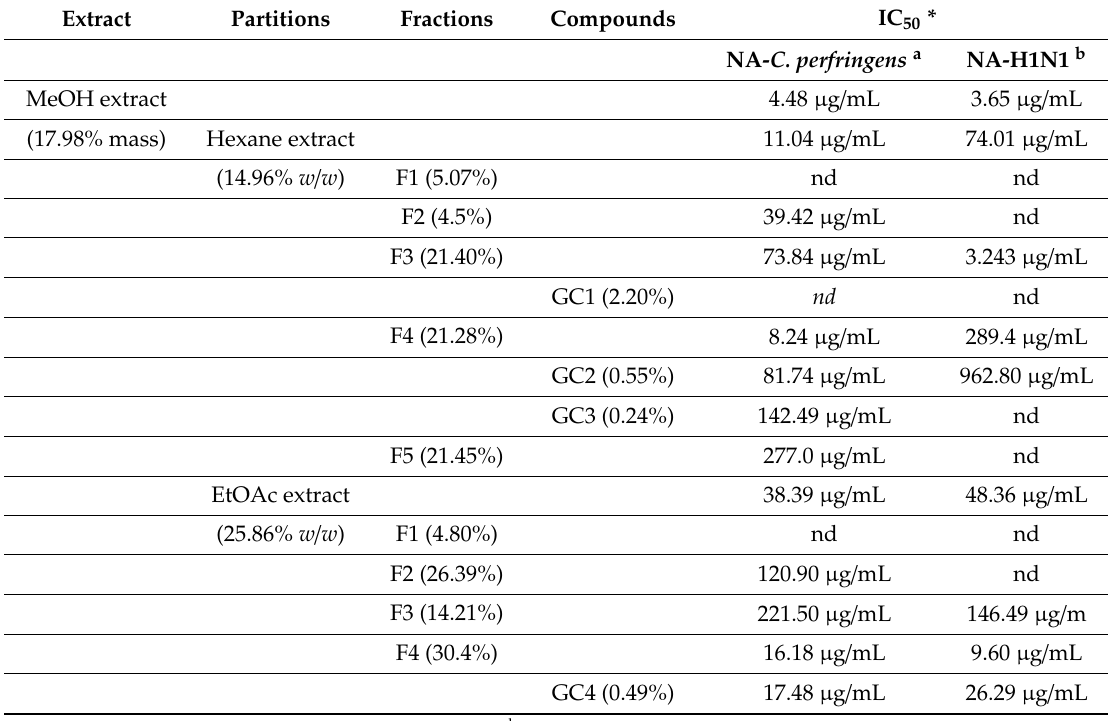
Table 1. Highlight of bioassay-guided isolation for NA inhibitors from